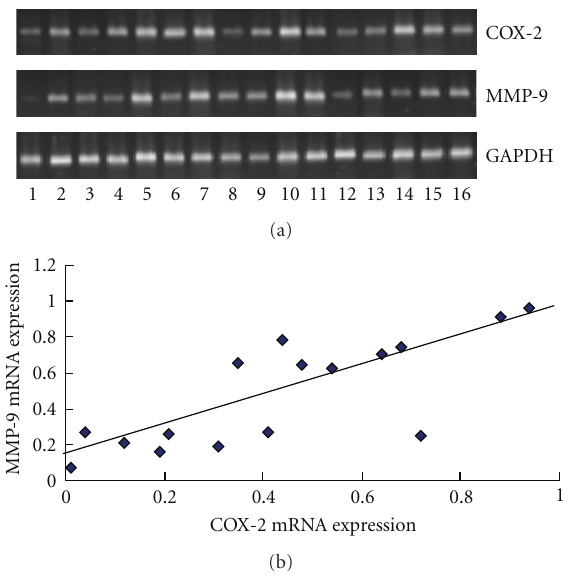
Figure 1: Expression of COX-2 and MMP-9 mRNA in pancreatic cancers. (a) Expression of COX-2 and MMP-9 mRNA was detected in 16 pancreatic cancers by RT-PCR. (b) Level of MMP-9 mRNA was correlated positively with that of COX-2 mRNA in 16 pancreatic cancers by real-time PCR, P < 0 . 01.